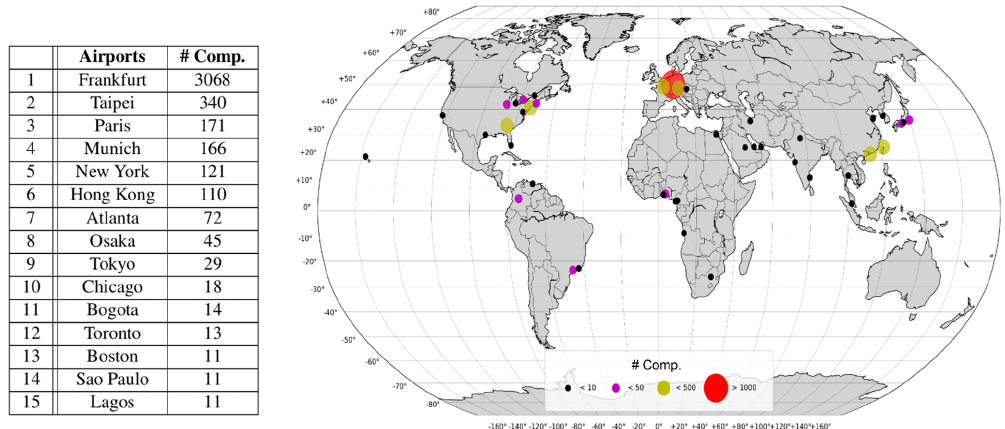
Figure 6. World map showing the total number of profile flight intercomparisons observed over airport cities since 1994 for the entire aircraft fleet. The criterion for the maximal time coincidence is 1h ( (cid:49)t max ≤